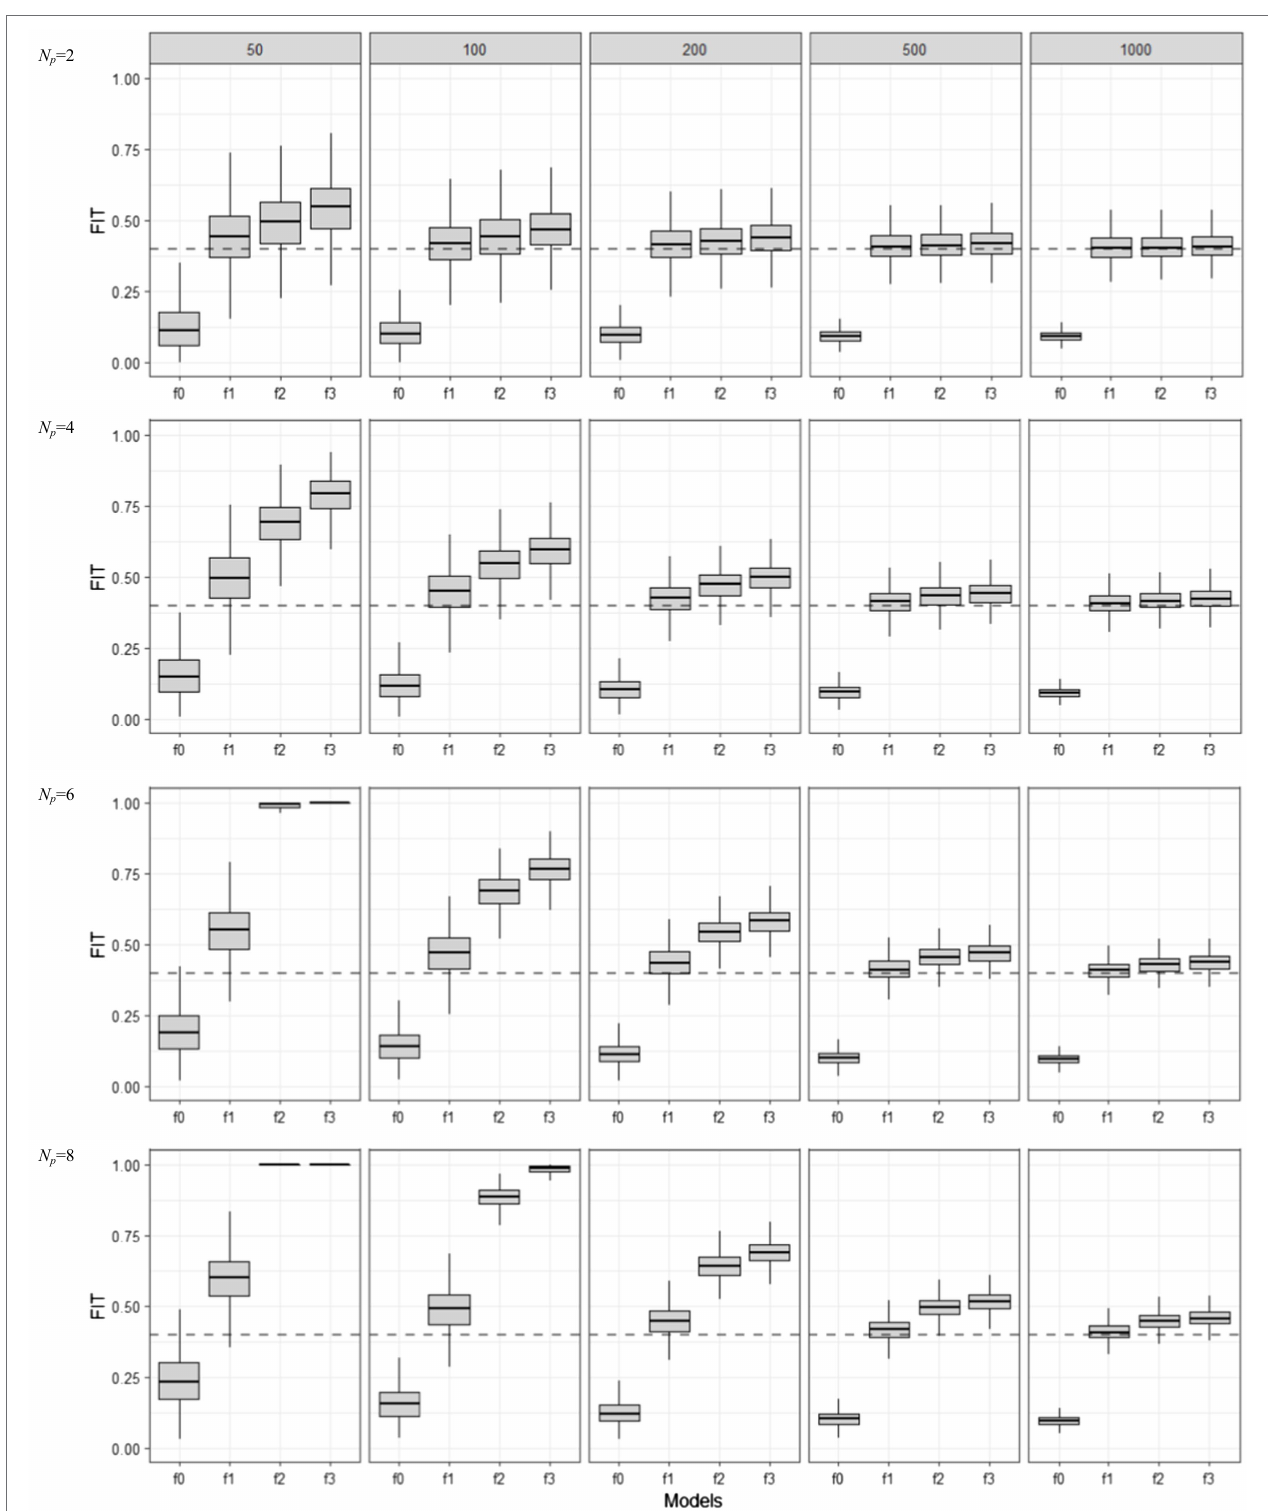
FIGURE 2 | Behavior of in-sample FIT values as the training set sample size ( N = 50, 100, 200, 500, 1,000) and model complexity ( Np = 2, 4, 6, 8) are varied for different model mis-specification conditions (f0, f1, f2, and f3). f1 is the true model, f0 is an under-specified model, and f2 and f3 are over-specified